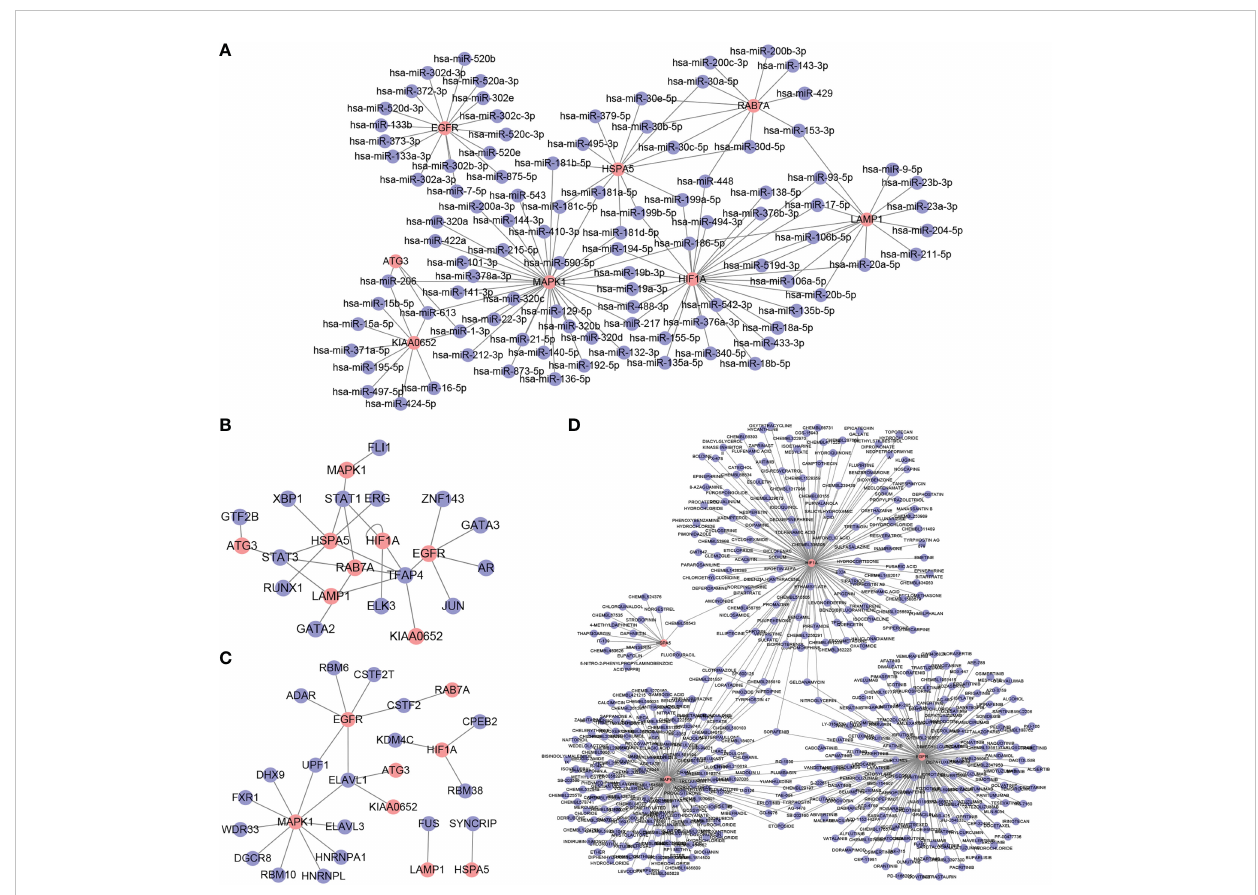
FIGURE 9 Hub gene – miRNA – transcription factor (TF) – RNA-binding protein (RBP) – drug network. (A) : Hub gene – miRNA network (B) : Hub gene – TF network (C) : Hub gene – RBP network (D) : Hub gene – drug network. The red nodes represent hub genes, and the blue nodes represent other molecules in the